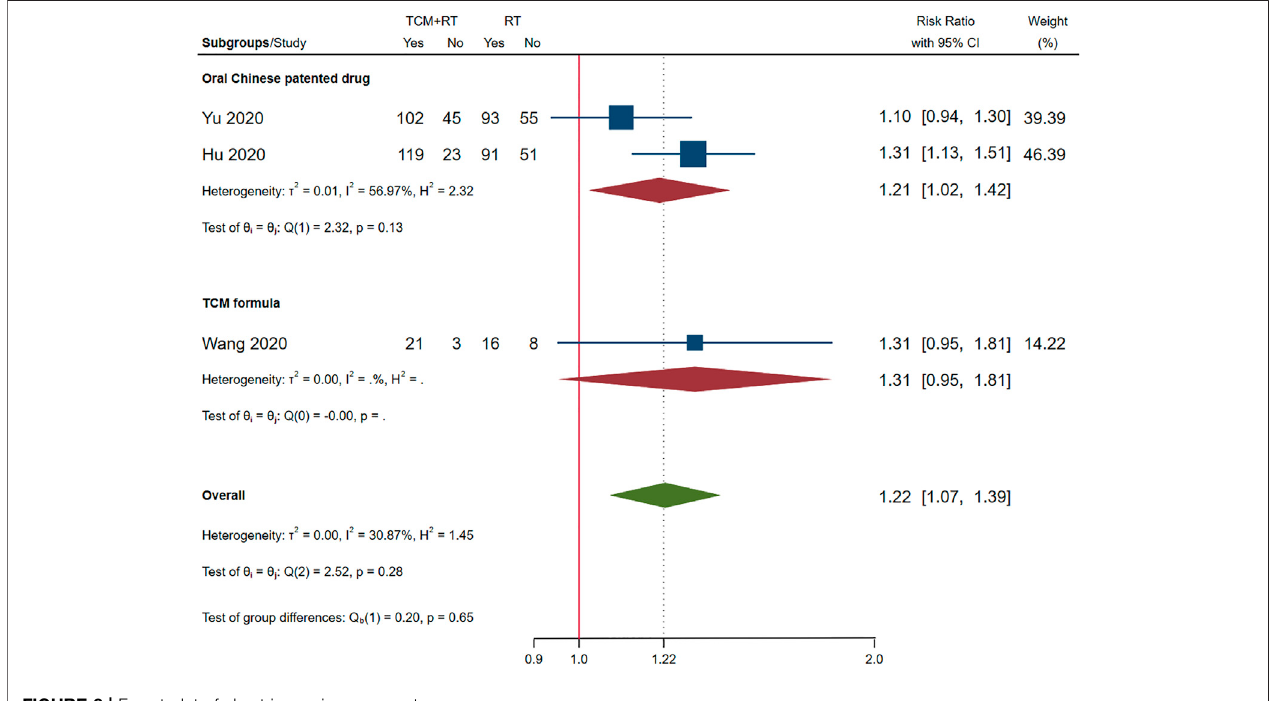
FIGURE 8 | Forest plot of chest image improvements.